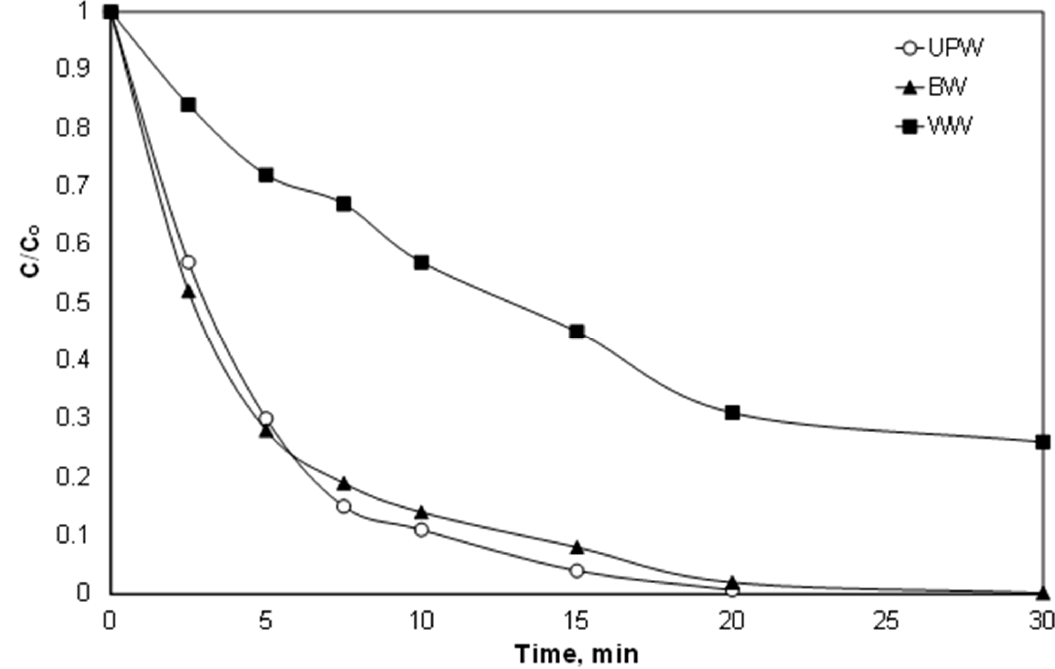
Figure 7. Effect of the water matrix on the oxidation of PIR. [PIR] = 500 µ g/L, [Fe 2+ ] = 2 mg/L, [SPS] = 20 mg/L, ultrapure water and inherent pH. UPW: ultrapure water BW: bottled water, WW: secondary effluent.